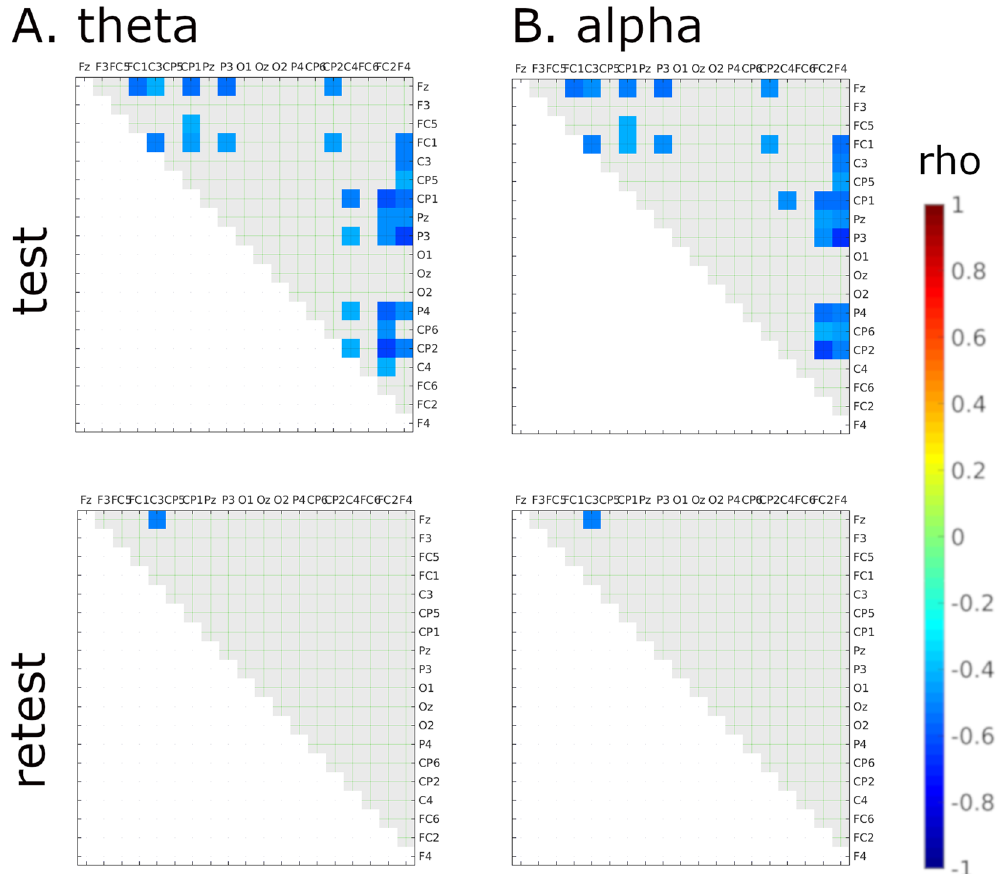
Figure 4. Significant correlations between gB2rest and PLVs in the shooting task (n = 23) during the expectation window in test (top row) and retest (bottom row) sessions were found only in theta ( A ) and alpha ( B ) bands. The color of individual squares denotes the correlation strength between the two electrodes that correspond to that square (uncorrected). Light gray squares denote lack of